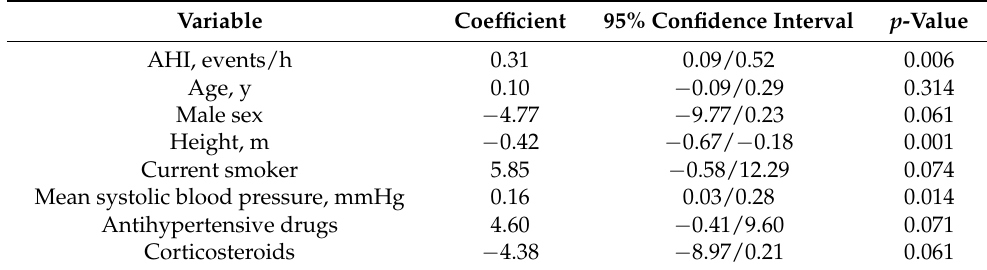
Table 3. Multivariable linear regression analysis of aortic AIx (AP/PP) normalized for a heart rate of 75/min and AHI, adjusted for known risk factors.